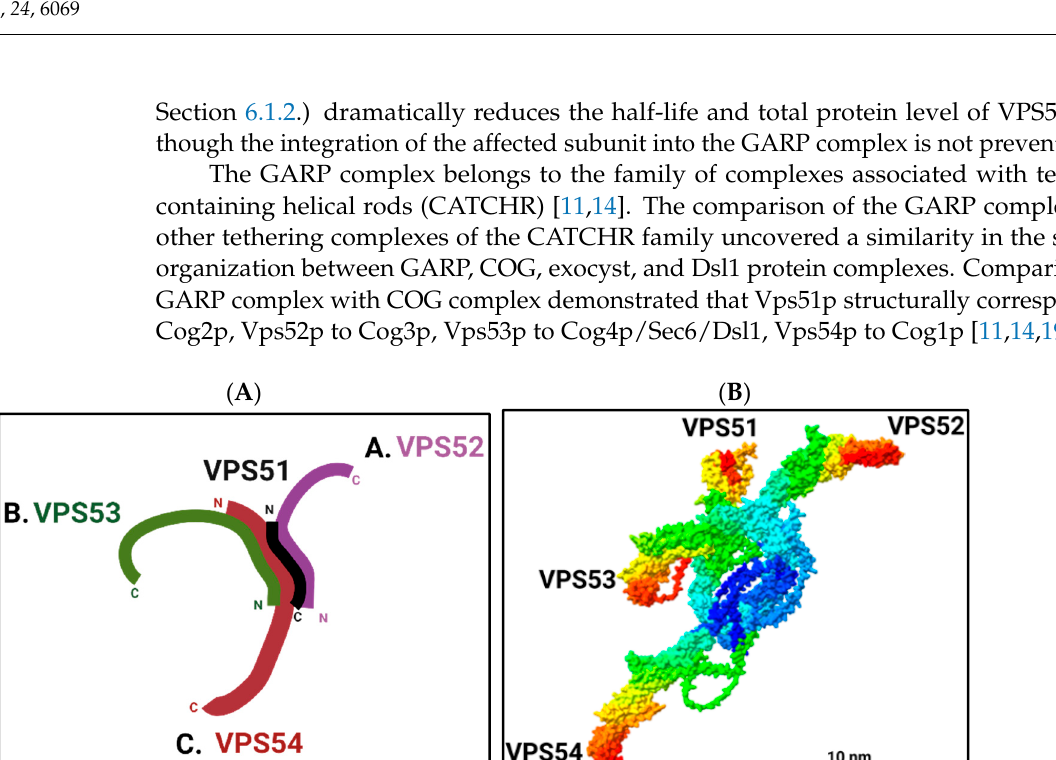
Figure 1. Structure of the GARP complex. ( A ) Schematic representation of the proposed 3D structure of yeast GARP complex based on negative-stain electron microscopy [11]. ( B ) AlphaFold structure prediction of human GARP complex. The N -terminal regions of VPS51 (1–194), VPS52 (1–178), VPS53 (1–169), and VPS54 (1–310) were used to assemble a 3D core structure of the GARP complex using the ColabFold [20] plugin of the UCSF ChimeraX program [21]. AlphaFold predicted 3D structures of individual subunits were fitted to the core structure using the “matchmaker” command of the UCSF ChimeraX program, and the resulting structures were colored using the Rainbow pale tt e. Scale bar is 10 nm. Predicted 3D structures of individual VPS51-54 human proteins were updated in AlphaFold DB version 2022-11-01, created with the AlphaFold Monomer v2.0 pipeline. The pre- dicted 3D structure of the GARP complex was assembled on 27 December 2022 and colored using ChimeraX.